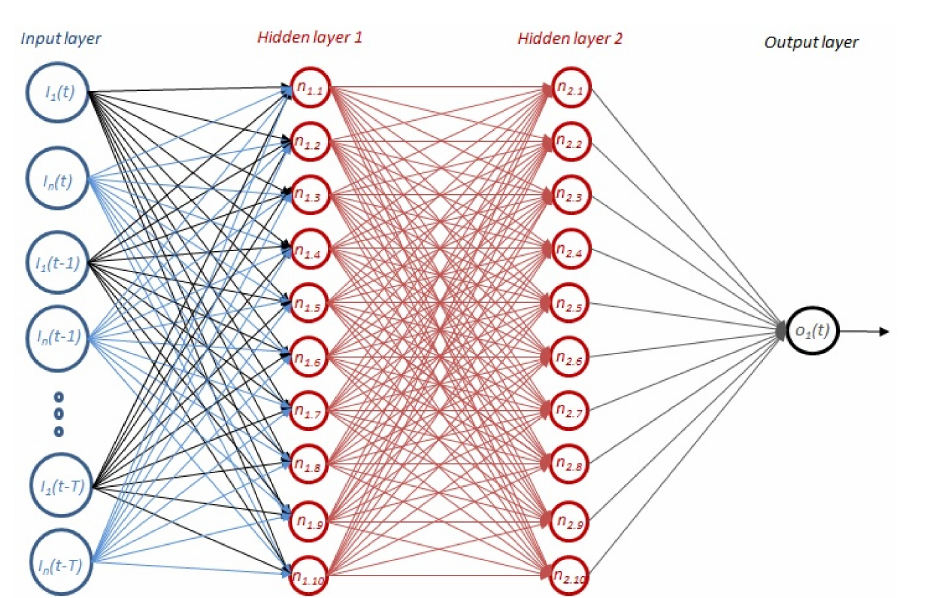
Figure 6. Diagram of time delay neural network (focused